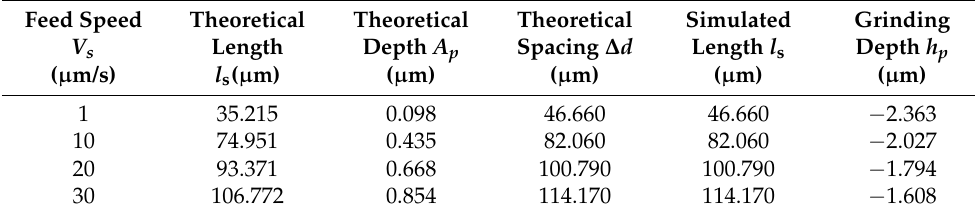
Table 6. Micro-pit dimension comparison of Group 3.